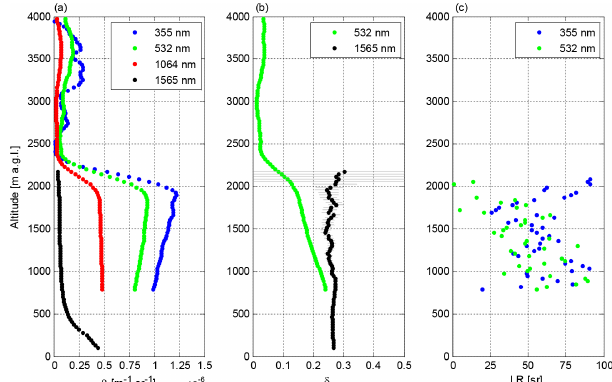
Figure 11. Averaged profiles at Limassol on 20 May 2017 at 19:55– 21:30UTC. All profiles have been smoothed by a 300m running mean. (a) Backscatter by PollyXT (wavelengths 355–1064nm) and attenuated backscatter by Halo (1565nm). (b) Particle linear de- polarization ratio. Error bars represent measurement uncertainty. (c) Lidar ratio. For PollyXT β 355 , β 532 , LR 355 and LR 532 , a near- range telescope is used for data < 900ma.g.l.